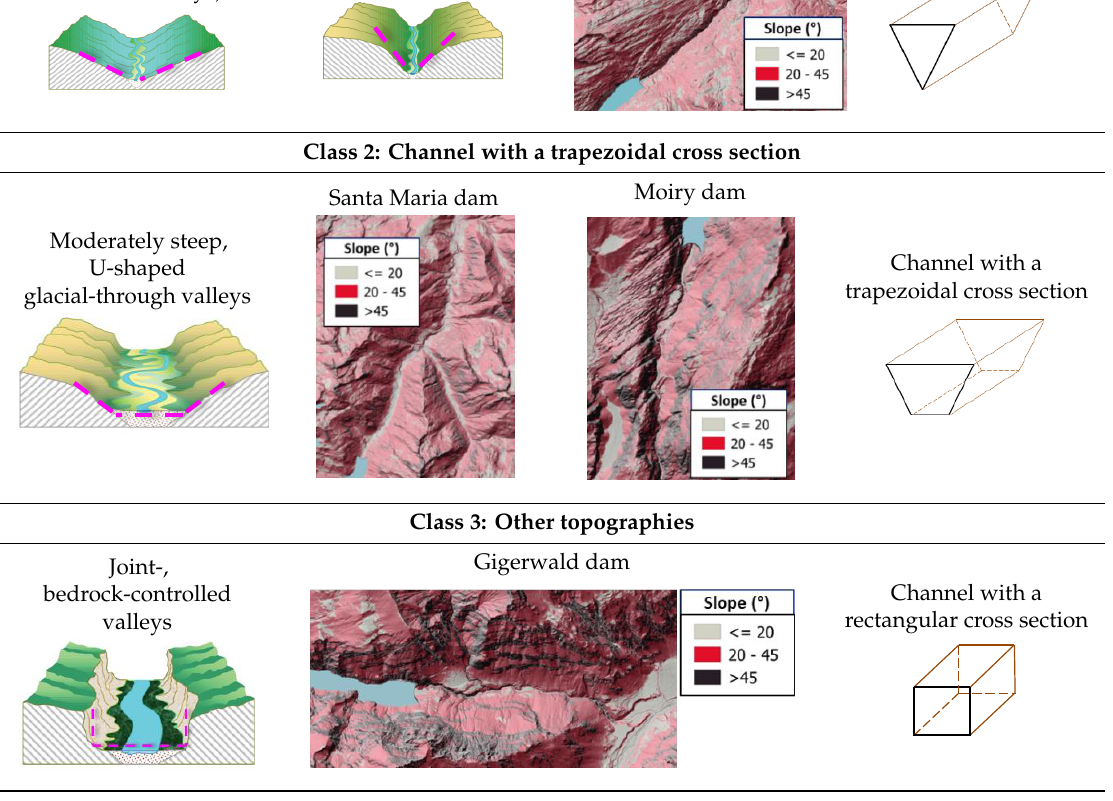
Class 3: Other topographies